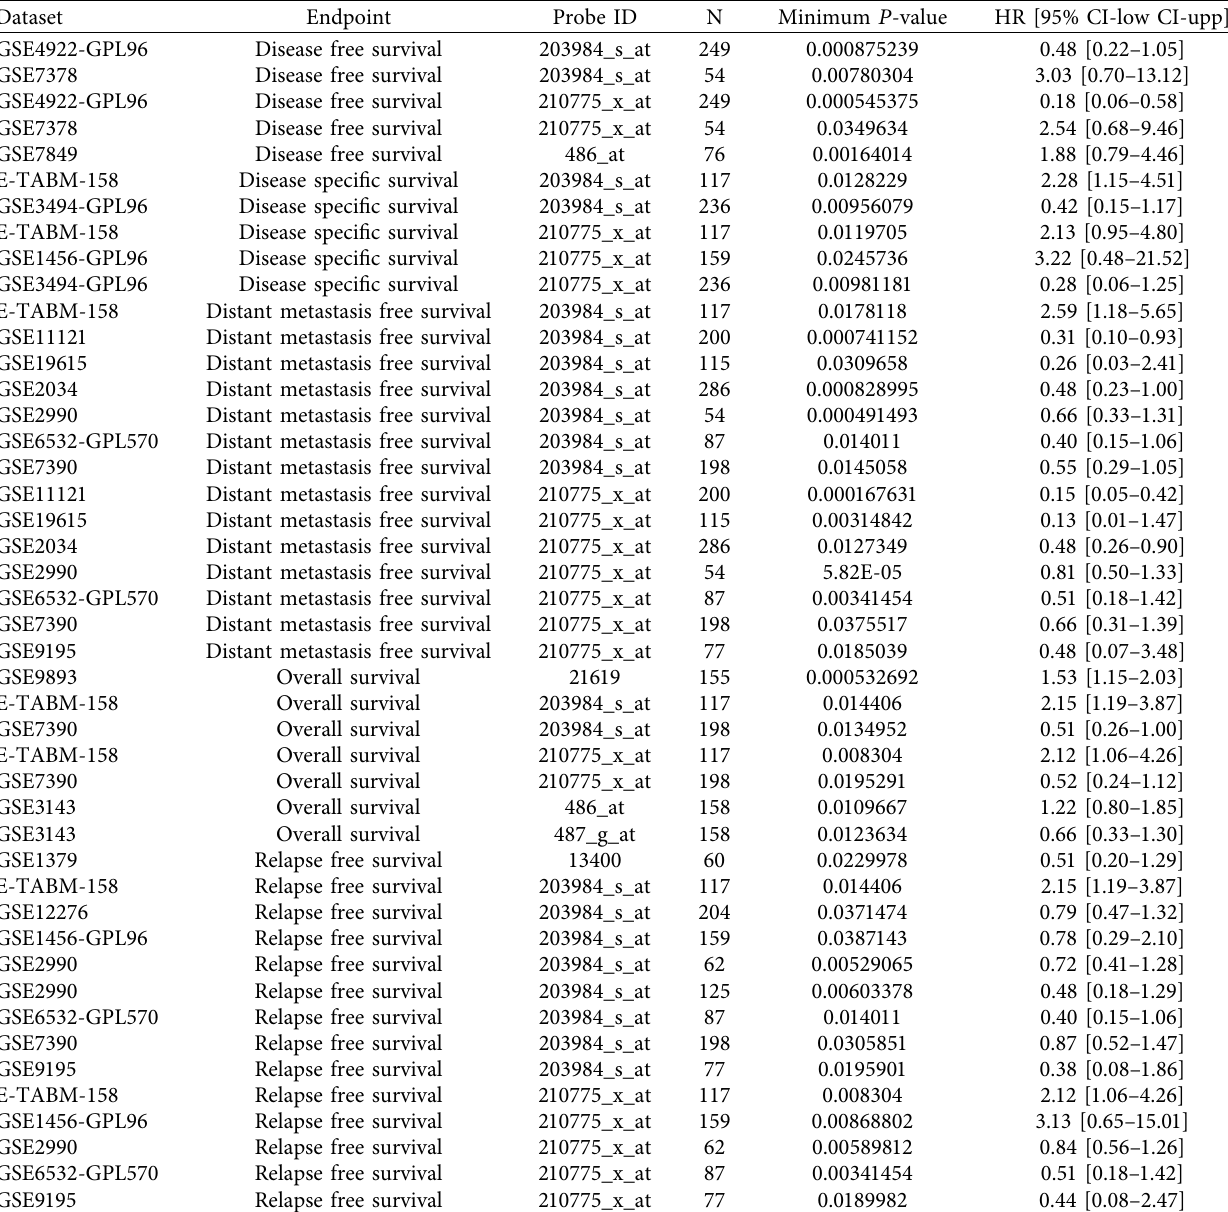
Table 5: CASP9 expression and survival data of breast cancer patients using the PrognoScan database. Dataset